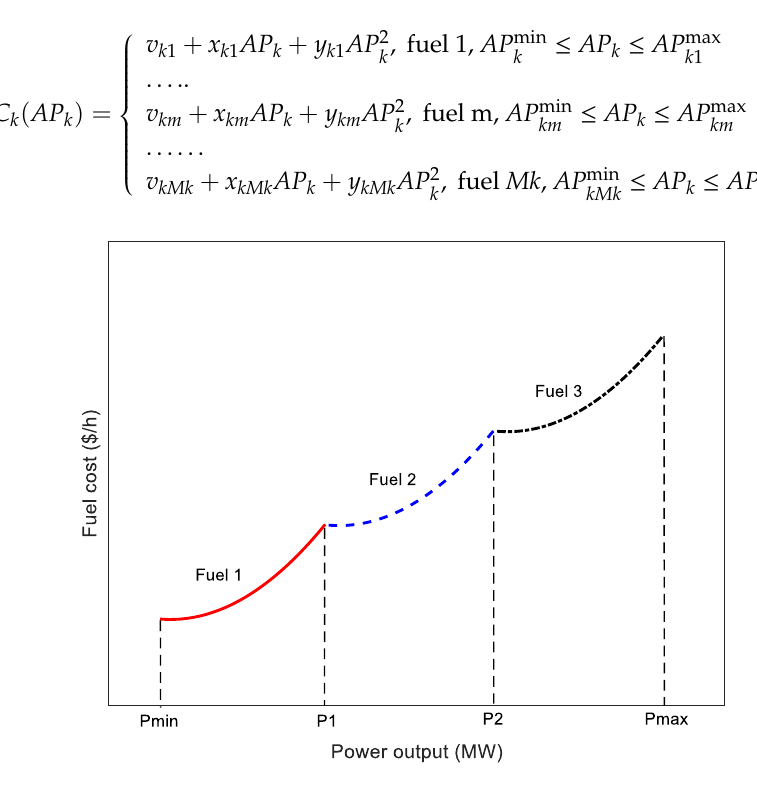
Figure 3. Fuel cost function for the case of multi-fuel options.